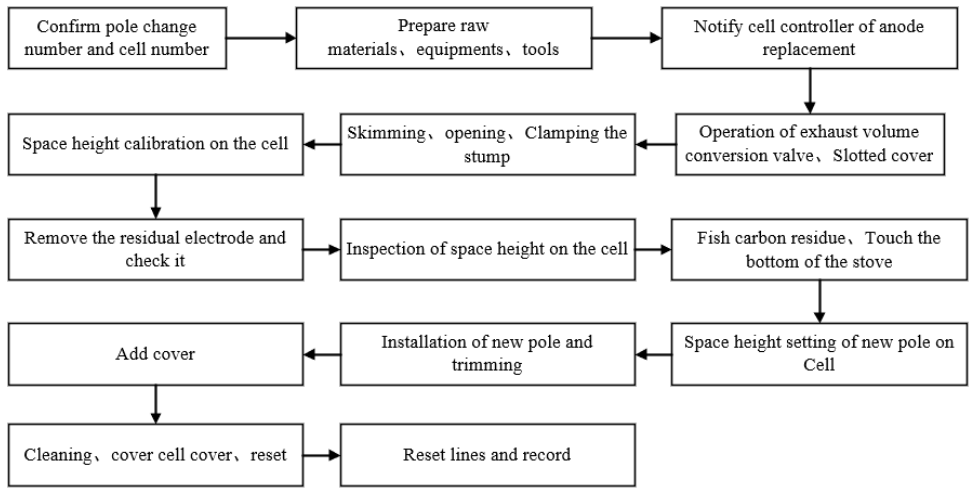
Figure 3. Flow chart of anode changing operation.